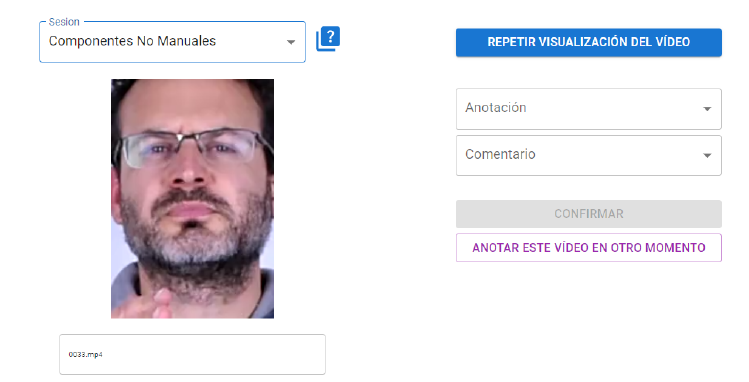
Figure 11. Screenshot of the web tool of LSE_GFE manual annotation.